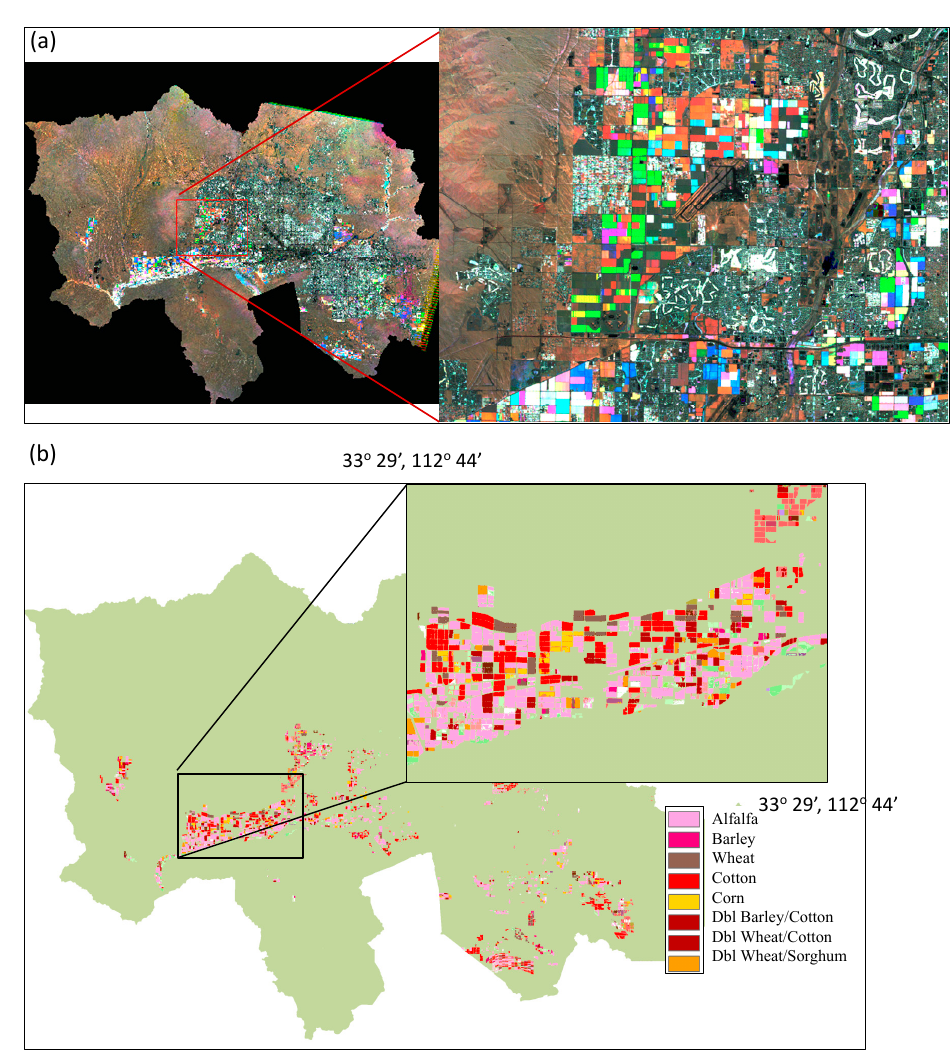
Figure 4. Landsat NDVI time series data and its crop type map. In total, 29 NDVI layers in 2001 ( a ) were used to generate its crop type map ( b ) using the support vector machine (SVM) classifiers.